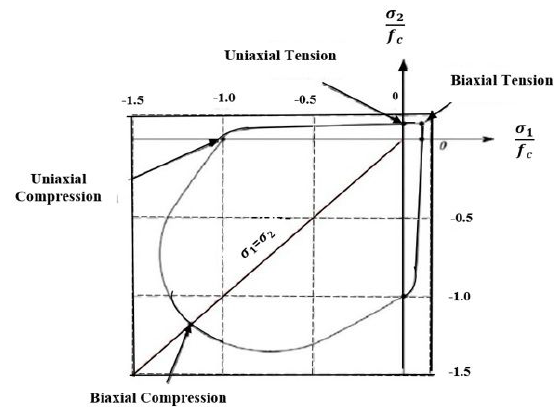
Figure 14: The yield surface in plane stress, adopted from Lee and Fenves [29]